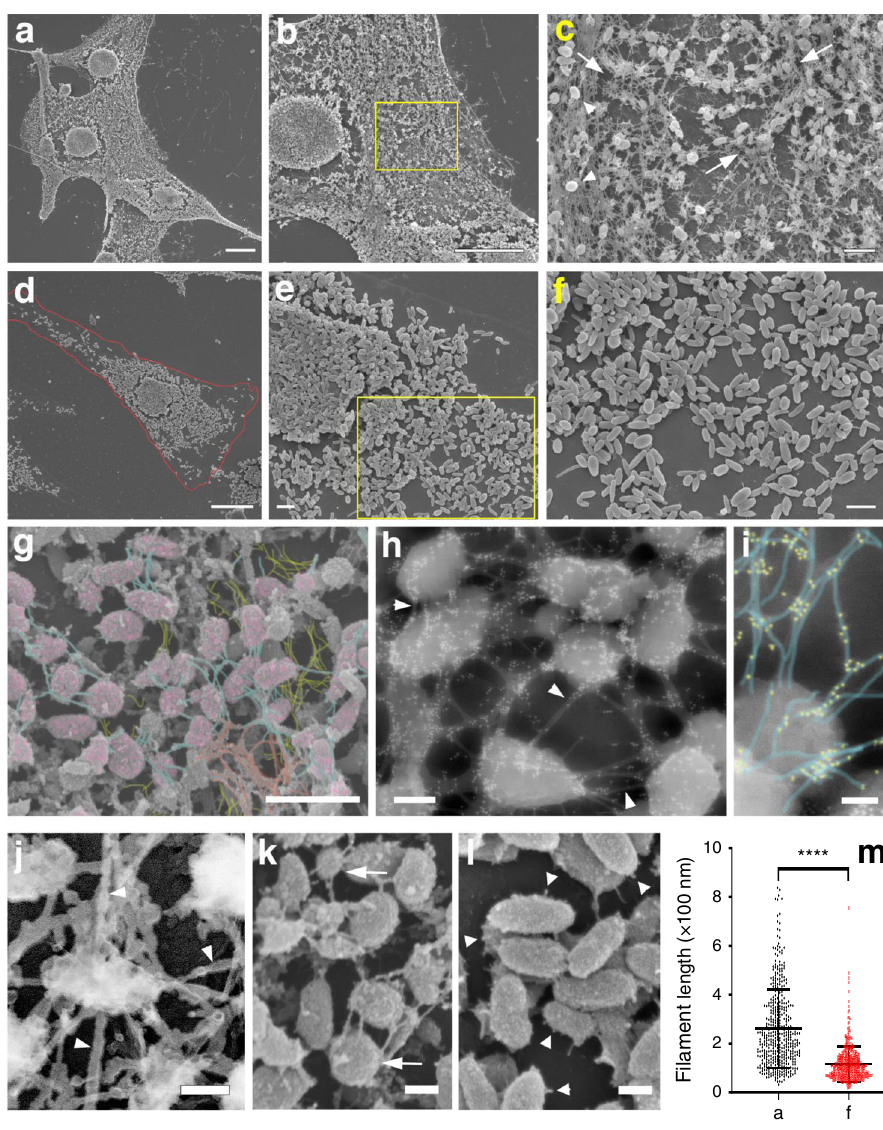
Fig. 3 High-resolution electron microscopy reveals a reduction in melanosome-associated AFs in FMN1-de fi cient melanocytes compared with controls. a – f Wild-type (melan-a, a – c ) and FMN1-de fi cient (melan - f, b – f ) cells were prepared for fi eld emission scanning electron microscopy (FESEM; see Experimental procedures). Cells in a and d are shown with increased magni fi cation, with high magni fi cation of the insets (yellow) in c and f . The red line in d indicates the cell outline. Arrows in c point at a loose network of fi laments around melanosomes; arrowheads show melanosomes on top of a dense fi lament network. g Colourised fi laments in high-magni fi cation FESEM images of melan-a melanosomes (pink) indicate fi laments linking (blue), above (orange) and below (yellow) melanosomes. h , i Immuno-electron microscopy of melan-a cells viewed with FESEM/backscatter showing phalloidin labelling (10 nm gold particles) of actin fi laments around and over melanosomes, as well as inter-melanosome fi laments (arrowheads). Higher magni fi cation in i shows colourised fi laments (cyan) and gold particle labelling (yellow). j TEM of rapid freeze/freeze dry metal replica showing myosin S1 decoration of fi laments (arrowheads) around melanosomes. g , k High-magni fi cation FESEM showing melanosomes with multiple AFs emerging from them in melan-a cells ( g , arrows) or AF stubs on melan-f melanosomes ( l , arrowheads). m Bee swarm plot showing size distribution for AFs emanating from melanosomes, as measured on FESEM images. n (actin fi laments) = 433 (melan-a) and 443 (melan-f). **** indicates signi fi cant difference p = <0.0001 between melan-a and melan-f cells as determined by Mann – Whitney test. Source data for i are provided in the supplementary Source data fi le. Bars indicate the mean and 25th and 75th percentile of data. Scale bars: a , b , d , 10 μ m; c , e – g , 1 μ m; h , k , l , 200 nm; i , j , 100